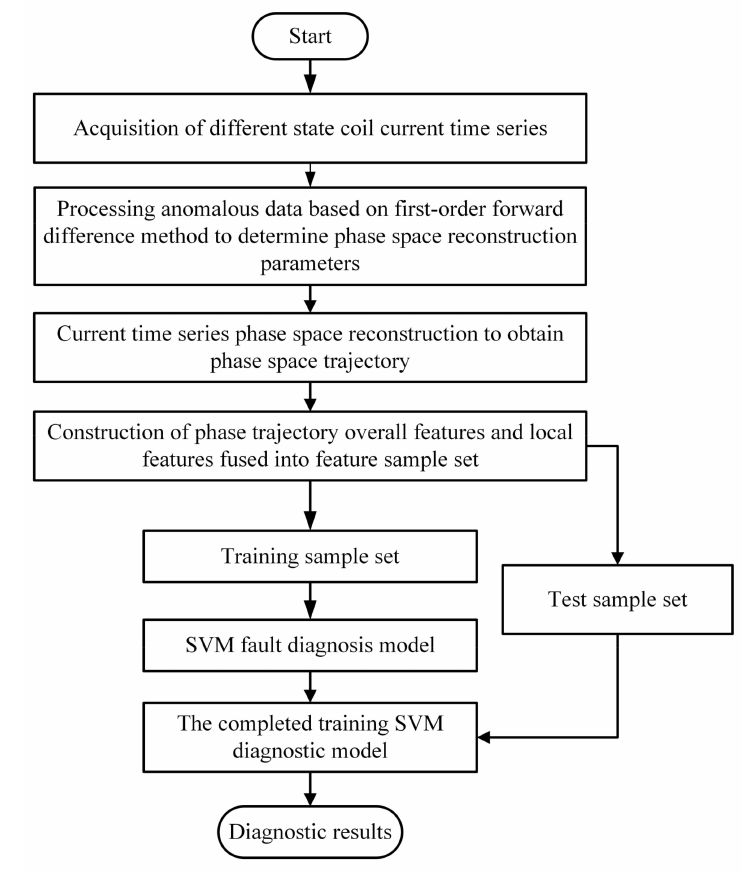
Figure 13. Overall fault identification